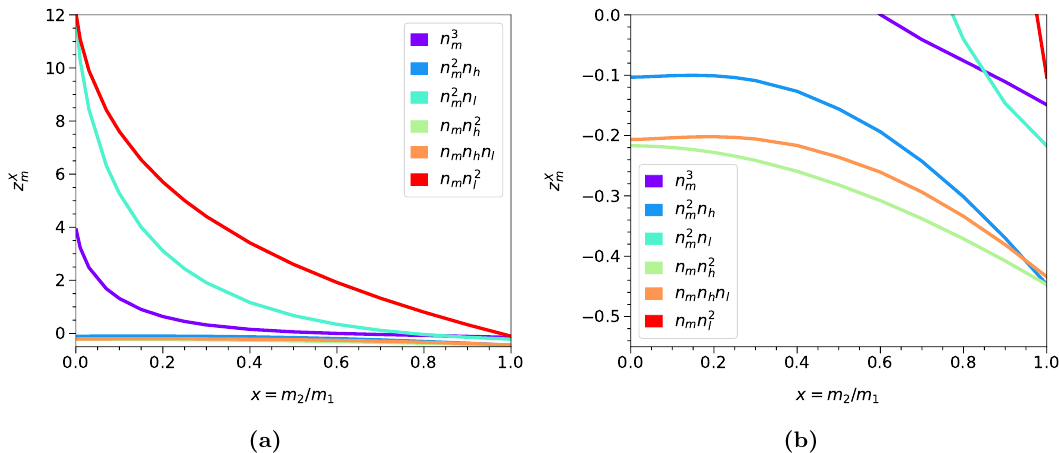
Figure 6 . The coefficients of all n 3